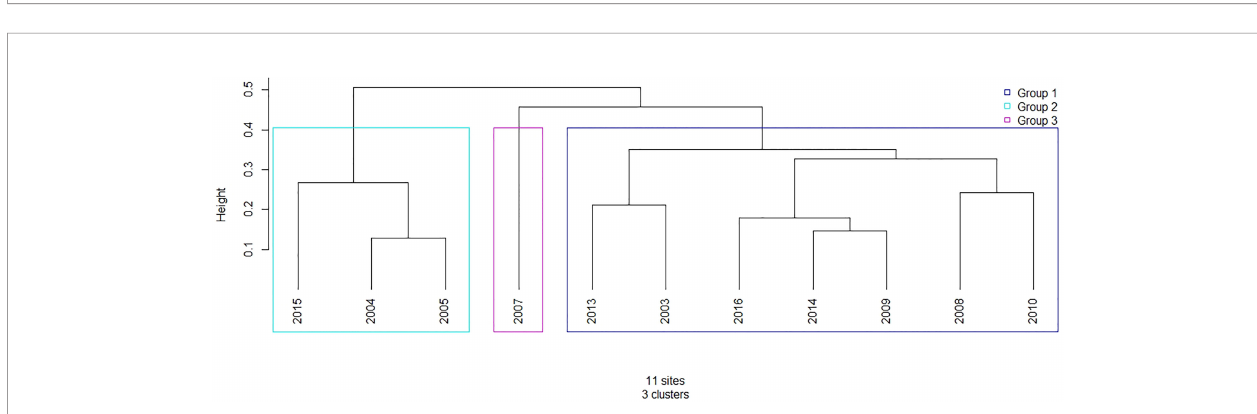
FIGURE 8 | Relationship between annual abundance (A) and biomass (B) of key crustacean taxa (i.e., groups that constitute major dietary items for juvenile salmon which also feed directly on phytoplankton; euphausiids, hyperiid amphipods, decapods, and the large calanoid copepod Neocalanus plumchrus ) and spring bloom start date in the Central Strait of Georgia,